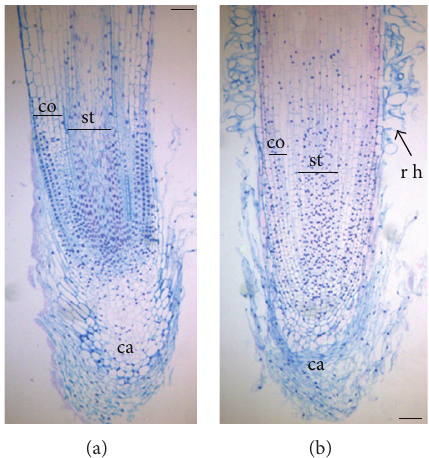
Figure 4: Longitudinal sections of embryonic (a) and adventitious (b) roots of Olea europaea L. subsp. europaea var. sylvestris , stained with periodic acid-Schiff’s reagent and 0.5% (w/v) Azur II. The adventitious roots were obtained from in vitro rooted cuttings. The embryonic roots come from in vitro germinated seeds. ca: calyptra, co: cortex, st: stele, rh: root hairs. (a) = 70 𝜇 m; (b) = 80 𝜇 m.